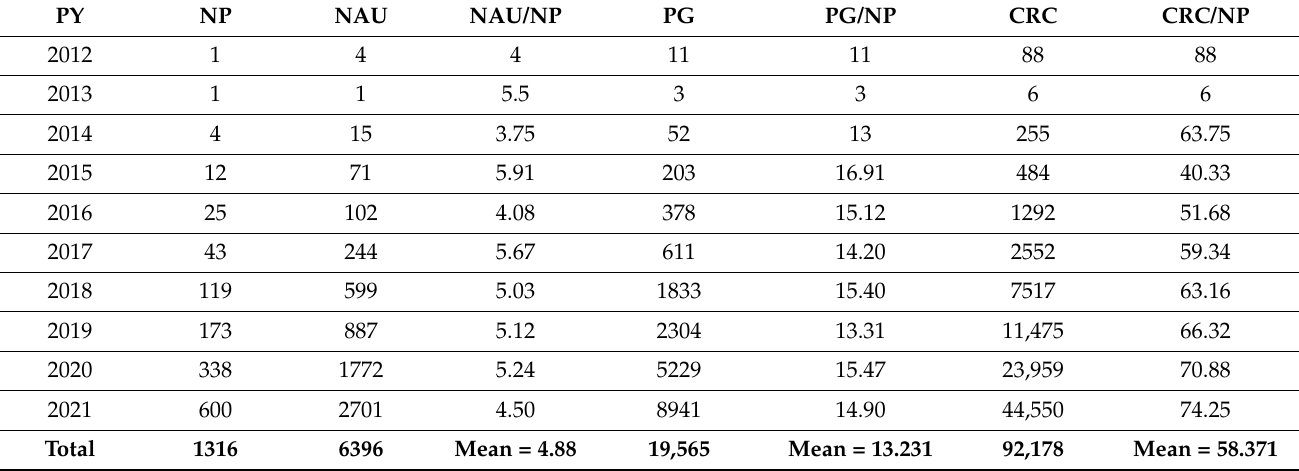
Table 1. Characteristics of annual publications on circular economy and foods during